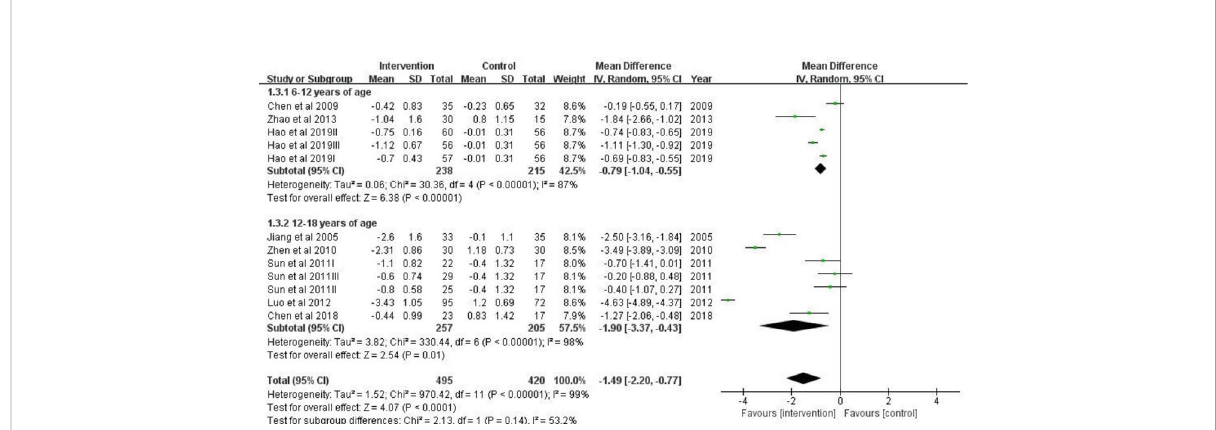
FIGURE 6 A forest plot providing data on the impact of lifestyle interventions on BMI with 95% con fi dence intervals of individual studies, grouped by age. Using a random effects model and an inverse variance method, a summary estimate of the 95% con fi dence interval was calculated. SD, standard deviation; IV, inverse variance; CI, con fi dence